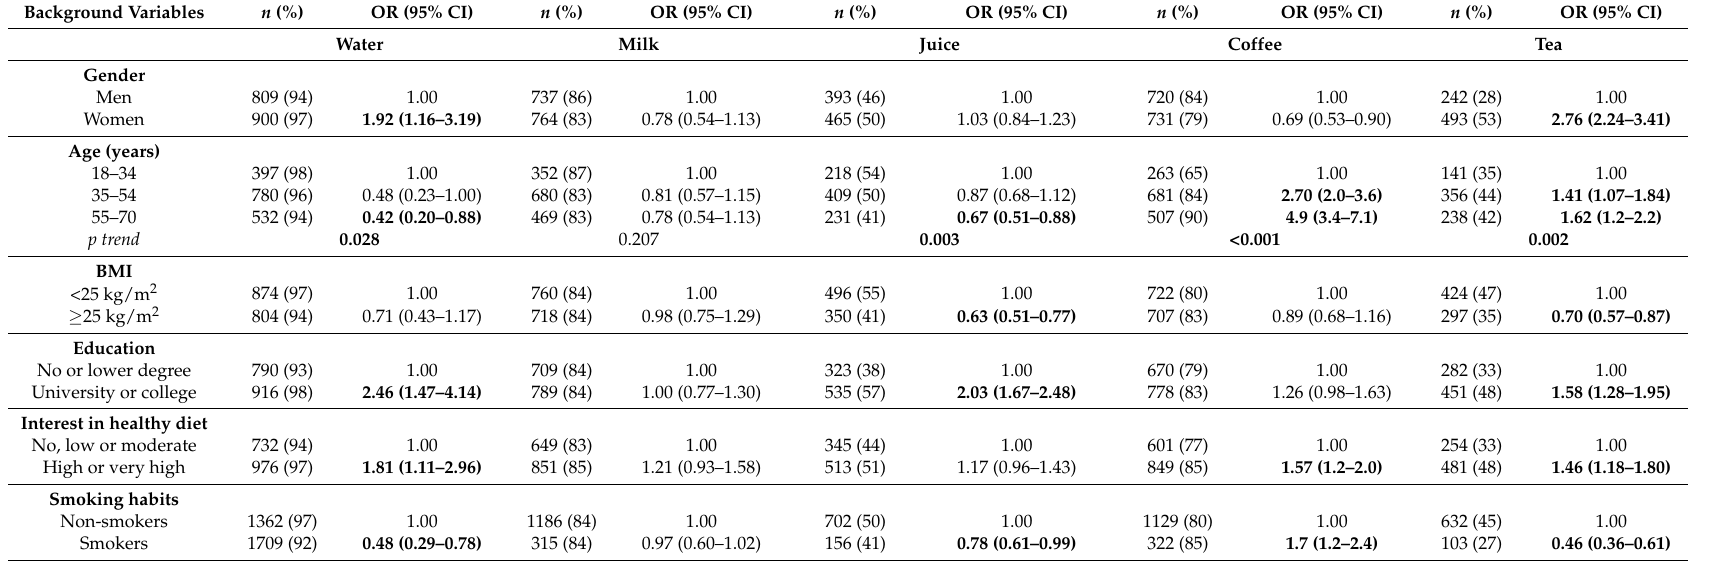
Table 4. Background characteristics associated with users and non-users of different beverage